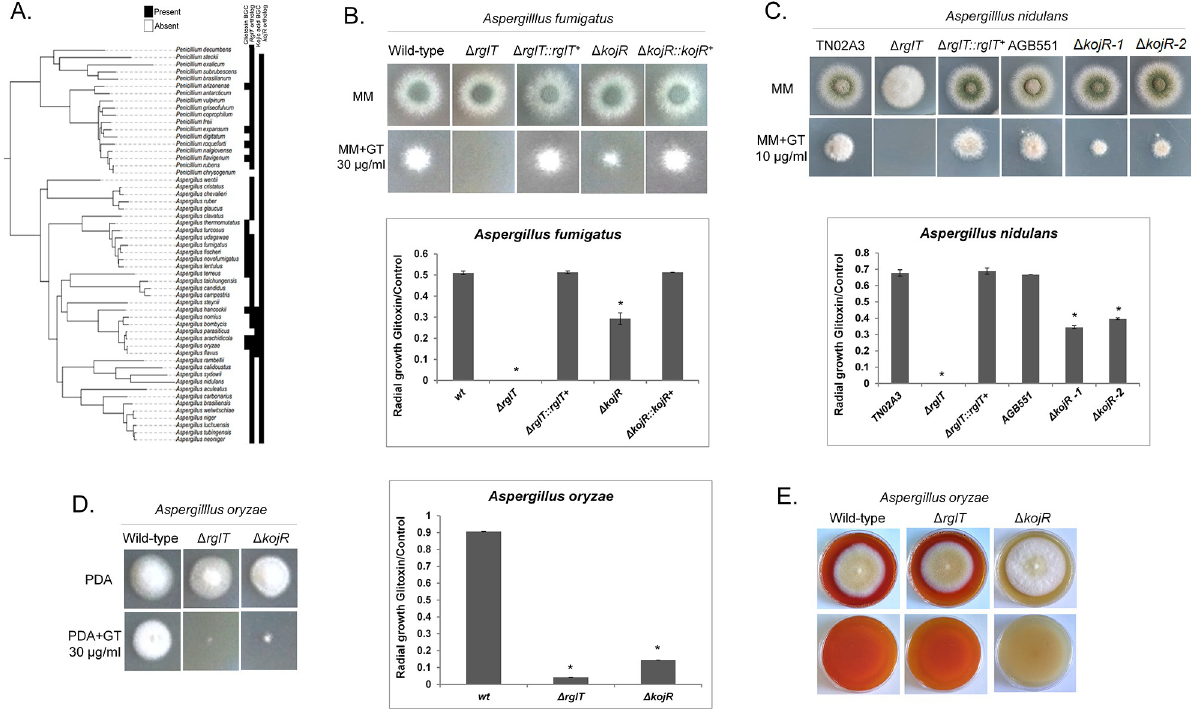
Fig 8. Aspergilli RglT and KojR homologs are important for gliotoxin production and self-protection. (A) Distribution of homologs of the gliotoxin and kojic acid biosynthetic gene clusters and of the RglT and KojR homologs amongst Aspergillus and Penicillium species. Homologs of the gliotoxin biosynthetic gene cluster are present across many (but not all) Aspergillus and Penicillium species, suggesting that the cluster was present in their common ancestor. Homologs of the kojic acid biosynthetic gene cluster are present only in Aspergillus oryzae and close relatives, suggesting that the cluster originated much more recently. Orthologs for RglT and KojR are broadly conserved in both genera, suggesting they were present in the Aspergillus–Penicillium common ancestor. Presence or absence of biosynthetic gene cluster homologs and of gene orthologs are depicted in black or white, respectively. (B-D) Pictures and graphs of the A . fumigatus (B), A . nidulans (C) and A . oryzae (D) wild-type, Δ rglT , and Δ kojR strains when grown for 48 h from 10 4 conidia at 37˚C on minimal medium (MM, A . fumigatus , A . nidulans ) or PDA ( A . oryzae ) and MM/PDA+10 or 30 μ g of gliotoxin. Graphs correspond to the radial diameter of the colony growth that is depicted in the pictures. Standard deviations represent the average of three biological replicates with � p < 0.05 in a one-tailed, paired t-test. (E) Detection of kojic acid (KA) production in A . oryzae in medium containing 1 mM ferric ion (FeCl 3 ). A red colour indicates the presence of KA chelated with ferric ions. The first and second rows indicate the top and bottom of the plates, respectively.